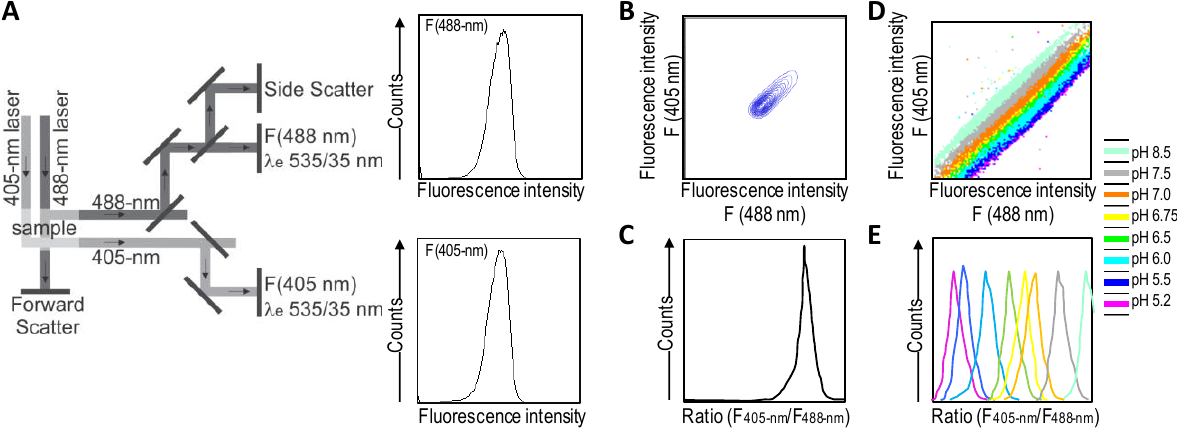
Figure 4. Flow cytometry for high-throughput analysis of cytosolic pH in cells expressing ratiometric pH sensors by excitation [31]. ( A ) The light paths of excitation at 405 and 488 nm and the emission optics are illustrated. Fluorescence intensity data are depicted for both detection channels—F(488 nm) and F(405 nm). ( B ) A 2D dot plot of F405-nm versus F488-nm shows grouped fluorescence signals. ( C ) The ratio of the fluorescence intensities of F(405 nm)/F(488 nm) plotted as the ratio height signal generates a narrow peak. ( D ) An overlay of 2D dot plots of F(405 nm) versus F(488 nm) for pH sensor at indicated pH values. ( E ) An overlay of ratios of the fluorescence intensities of F(405 nm)/F(488 nm) depicted from ( F ). Note: In less than 2 min, the fluorescence signals of 50,000 cells can be analyzed and